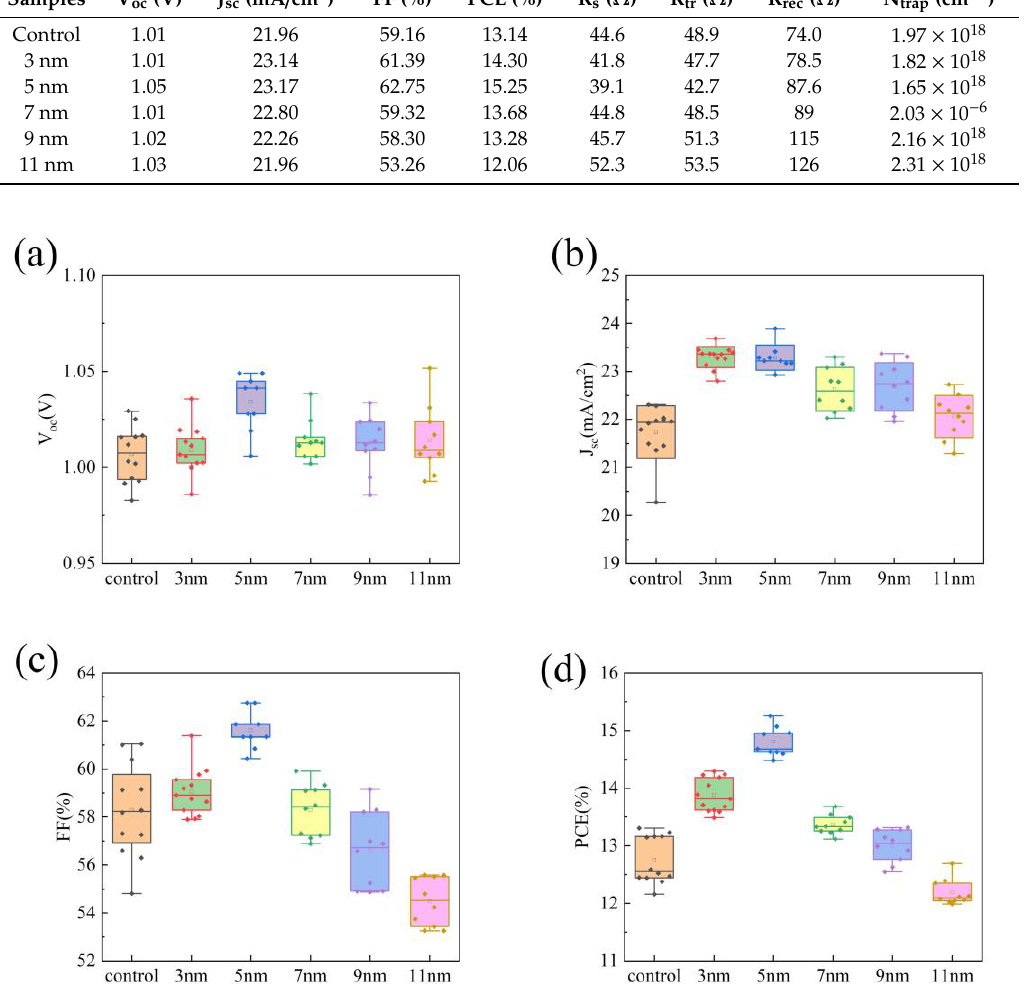
Figure 6. Box plots of PSCs’ photoelectric properties with Ag@SiO 2 core-shell nanoparticles with a different shell thickness: ( a ) open circuit voltage, ( b ) short-circuit current value, ( c ) fill factor, and ( d ) photoelectric conversion efficiency. Table 2. Relevant properties parameters of the PSCs with Ag@SiO 2 core-shell nanoparticles (NPs) with a different shell thickness.